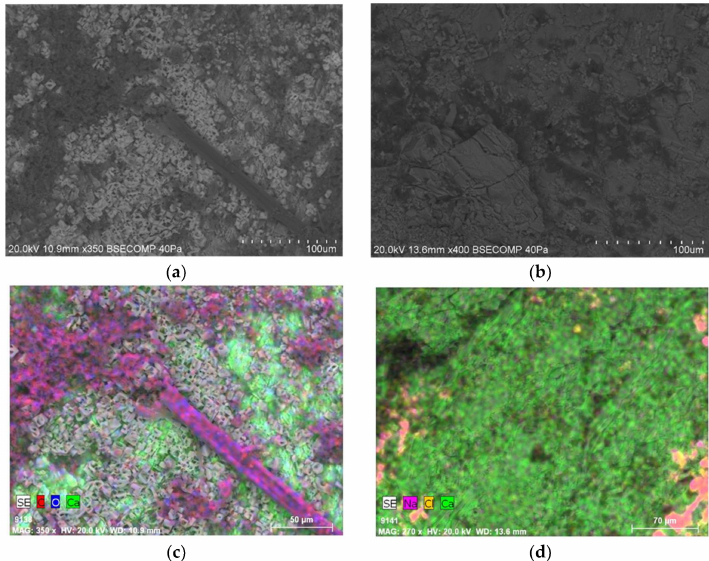
Figure 5. Antifungal activity of the bioactive compounds produced by Bacillus sp. CCLBH 1053 and commercial antifungal drugs against biodeteriogenic fungi isolated from deteriorated mural paintings.